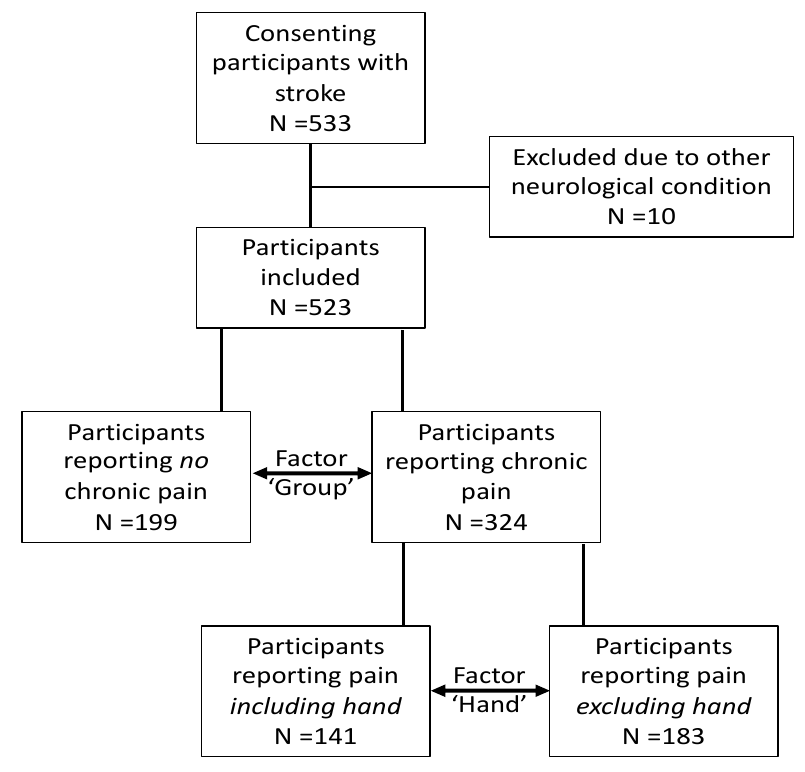
Figure 1. Flow of participants through the study. Table 1. Comparison of demographic, clinical and hand size data for stroke survivors with and without reported chronic pain. The mean age and duration post-stroke for each group, frequency of reported altered perceived hand size, hemispheric side of lesion and gender distribution are reported in Table 1. Ten participants chose not to indicate that they identified as being either female or male. Seventy-one of participants did not indicate the side of their stroke, selecting “unknown” or choosing to leave it blank, while eight participants who indicated that their hand now felt a different size failed to indicate whether it was either “bigger” or “smaller”. Thirty-seven participants reported that they had been diagnosed as having CRPS of the hand, representing 27% of those with chronic hand pain post-stroke.